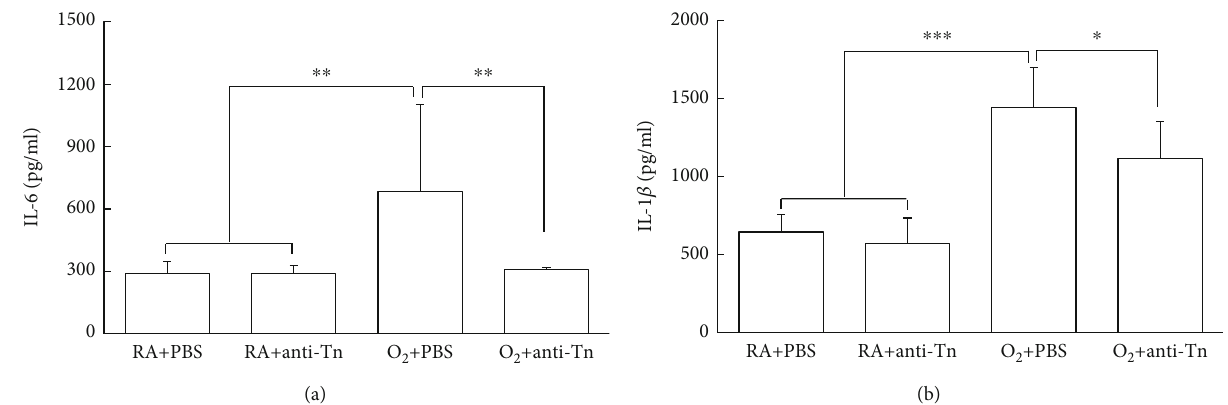
Figure 4: Anti-Tn monoclonal antibody treatment reduced the hyperoxia-induced increase in cytokine levels in 7-day-old mice. The mice reared in hyperoxia and treated with PBS exhibited signi fi cantly higher IL-6 and IL-1 β than did those reared in RA and treated with PBS or anti-Tn monoclonal antibodies. Treatment with anti-Tn monoclonal antibodies signi fi cantly decreased the hyperoxia-induced increase in IL-6 and IL-1 β levels. ∗ P < 0 : 05 , ∗∗ P < 0 : 01 , ∗∗∗ P < 0 : 001